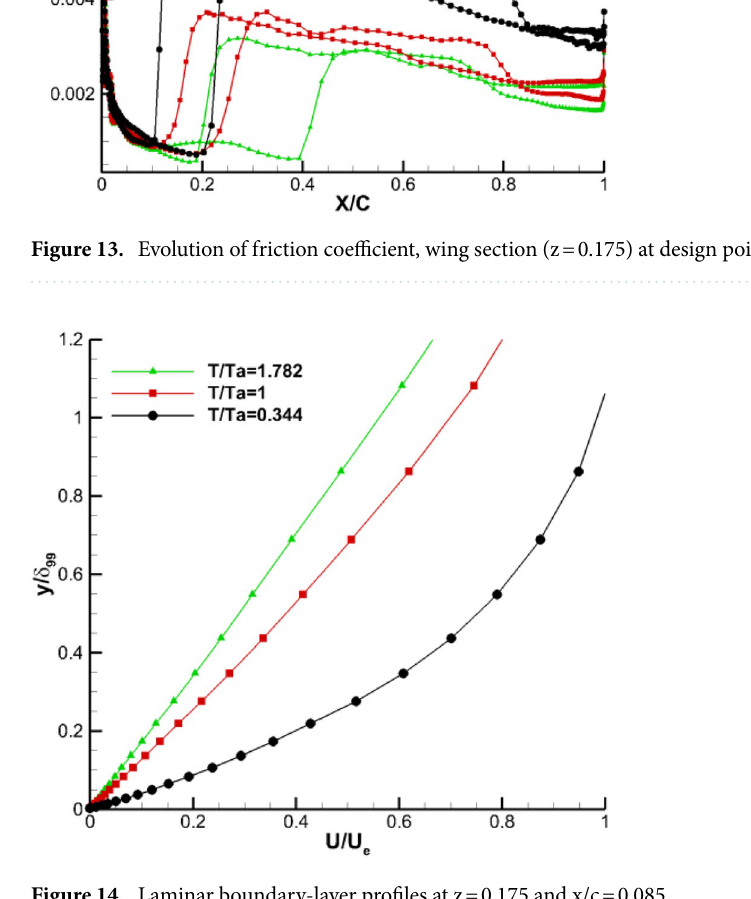
Figure 14. Laminar boundary-layer profiles at z = 0.175 and x/c =